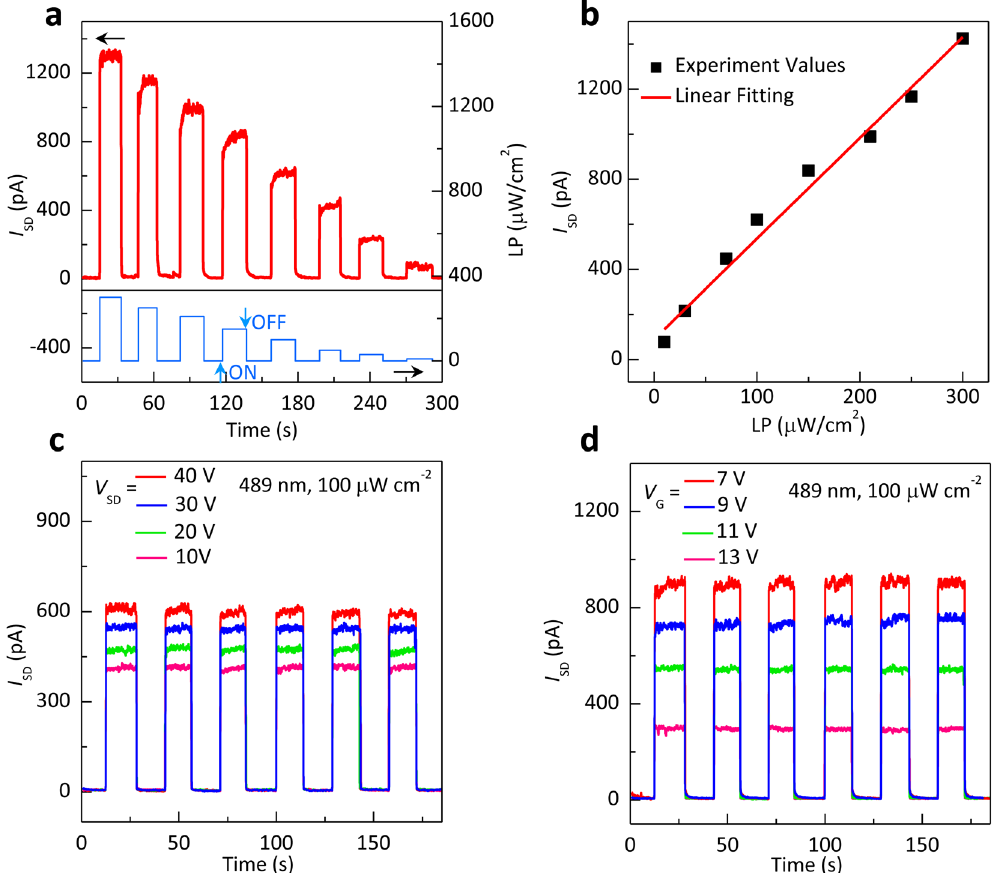
Figure 4. Dynamic photoresponse behavior of the PTCDI-C 13 H 27 thin-film phototransistor. ( a ) Dynamic photoresponse under different irradiation (10, 30, 50, 100, 150, 210, 250, 300 μ W cm − 2 ) at fixed V G = 9 V. ( b ) Light power density dependence of the photocurrent. ( c ) Dynamic photoresponse behavior of PTCDI-C 13 H 27 OPT with different V G at fixed V SD = 30 V under the irradiation of 100 μ W cm − 2 . ( d ) Dynamic photocurrent response of PTCDI-C 13 H 27 OPT with different V SD at V G = 9